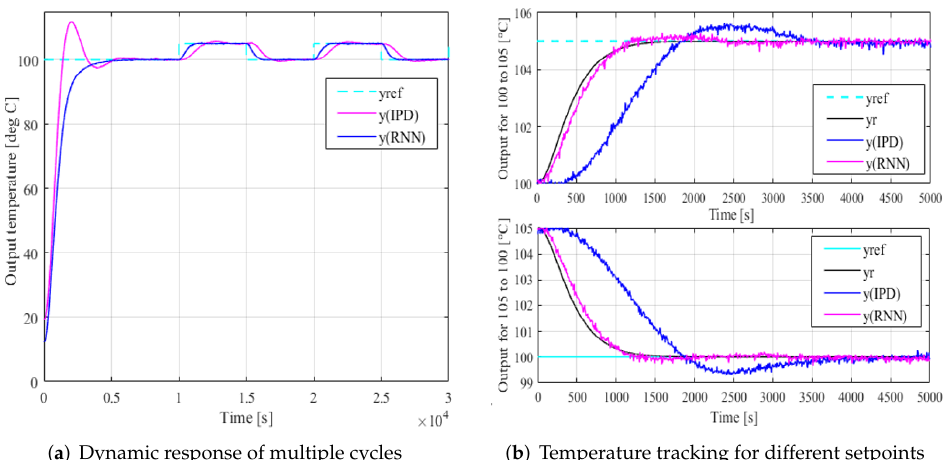
Figure 5. Dynamic responses of the control process with IPD and RNN controller, respectively. ( a ) The whole response for temperature goes from room temperature to a setpoint and then repeatedly responds to the rising and falling step signals. ( b ) The temperature change in positive and negative directions over a full cycle.